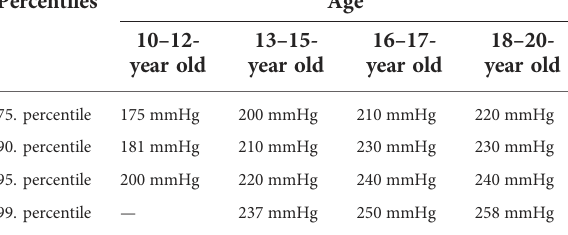
TABLE 7 Age dependent blood pressure percentiles of male junior